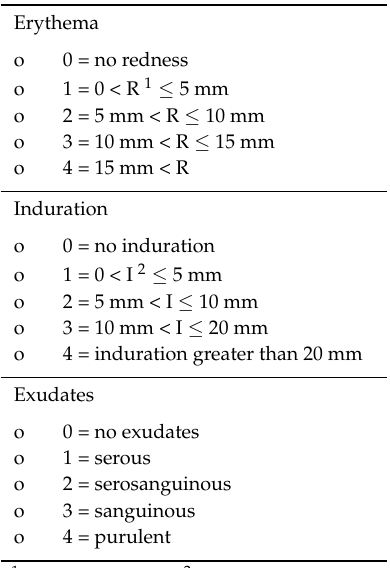
Table 2. Peristomal